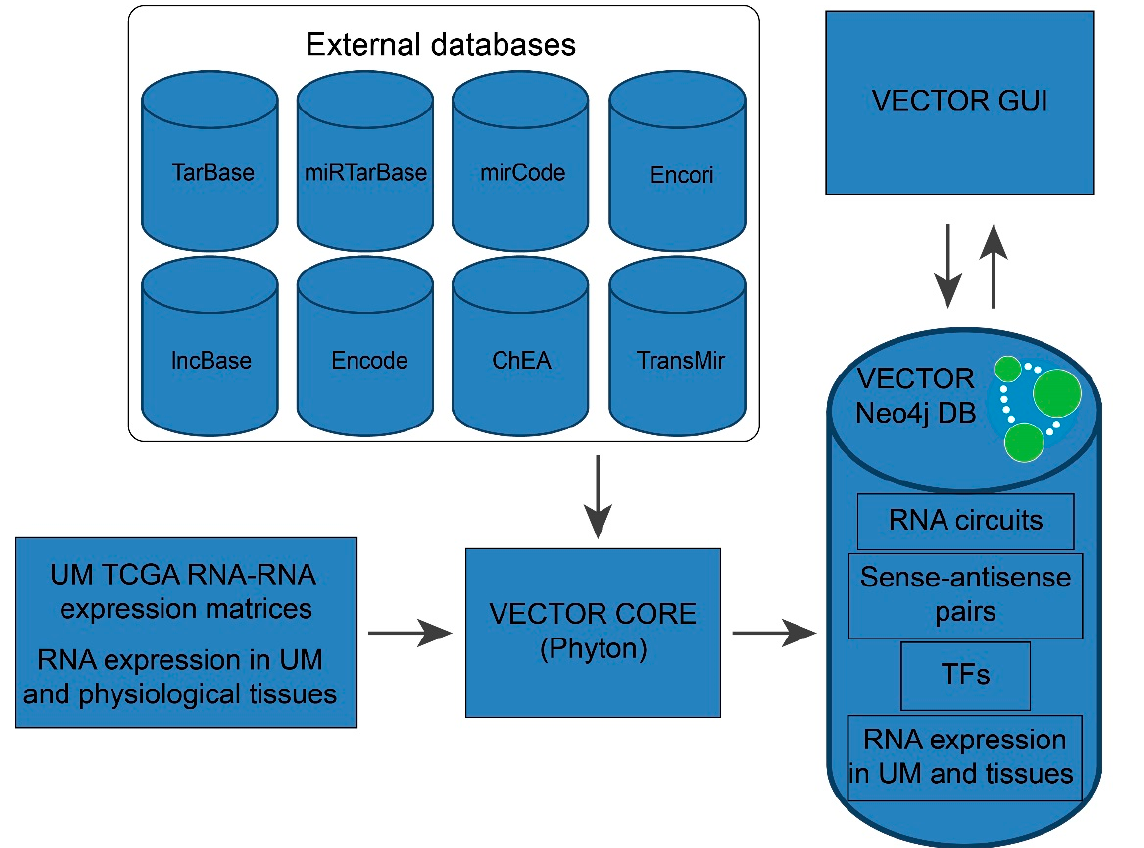
Figure 1. Architecture of VECT model. Cylinders represent databases (both external databases and VECTOR); rectangles depict graphical interface modules or database processing applications. Neo4j database logo is shown within the VECTOR database.